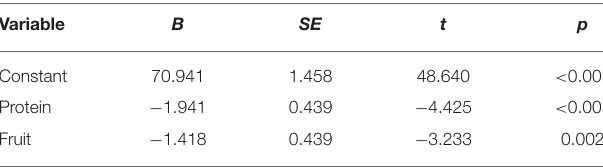
TABLE 4 | Regression analysis of diet consumption on general bowel